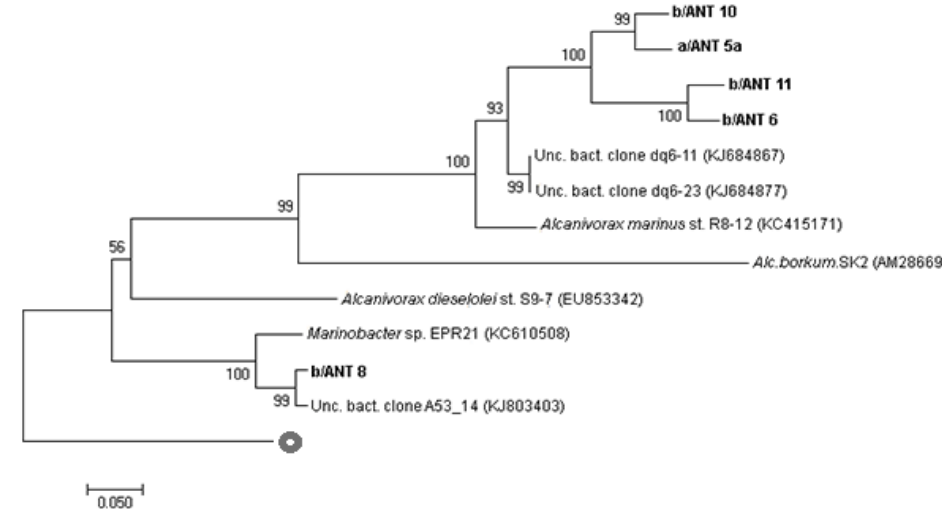
Figure 2. Rooted phylogenetic tree clustered by neighbour-joining of maximum likelihood values showing gene sequences to closest related sequences from Alcanivorax spp. Isolates are indicated in bold-type. Percentages of 1000-bootstrap resampling that supported the branching orders in each analysis are shown above or near the relevant nodes. All trees were rooted and outgrouped with alk-B1 gene sequences of Novosphingobium sp. PCY alkane monooxygenase gene (KJ650249). Vertical lines indicate evolutionary distance; each scale bar length corresponds to 0.05 fixed point mutations per sequence position.